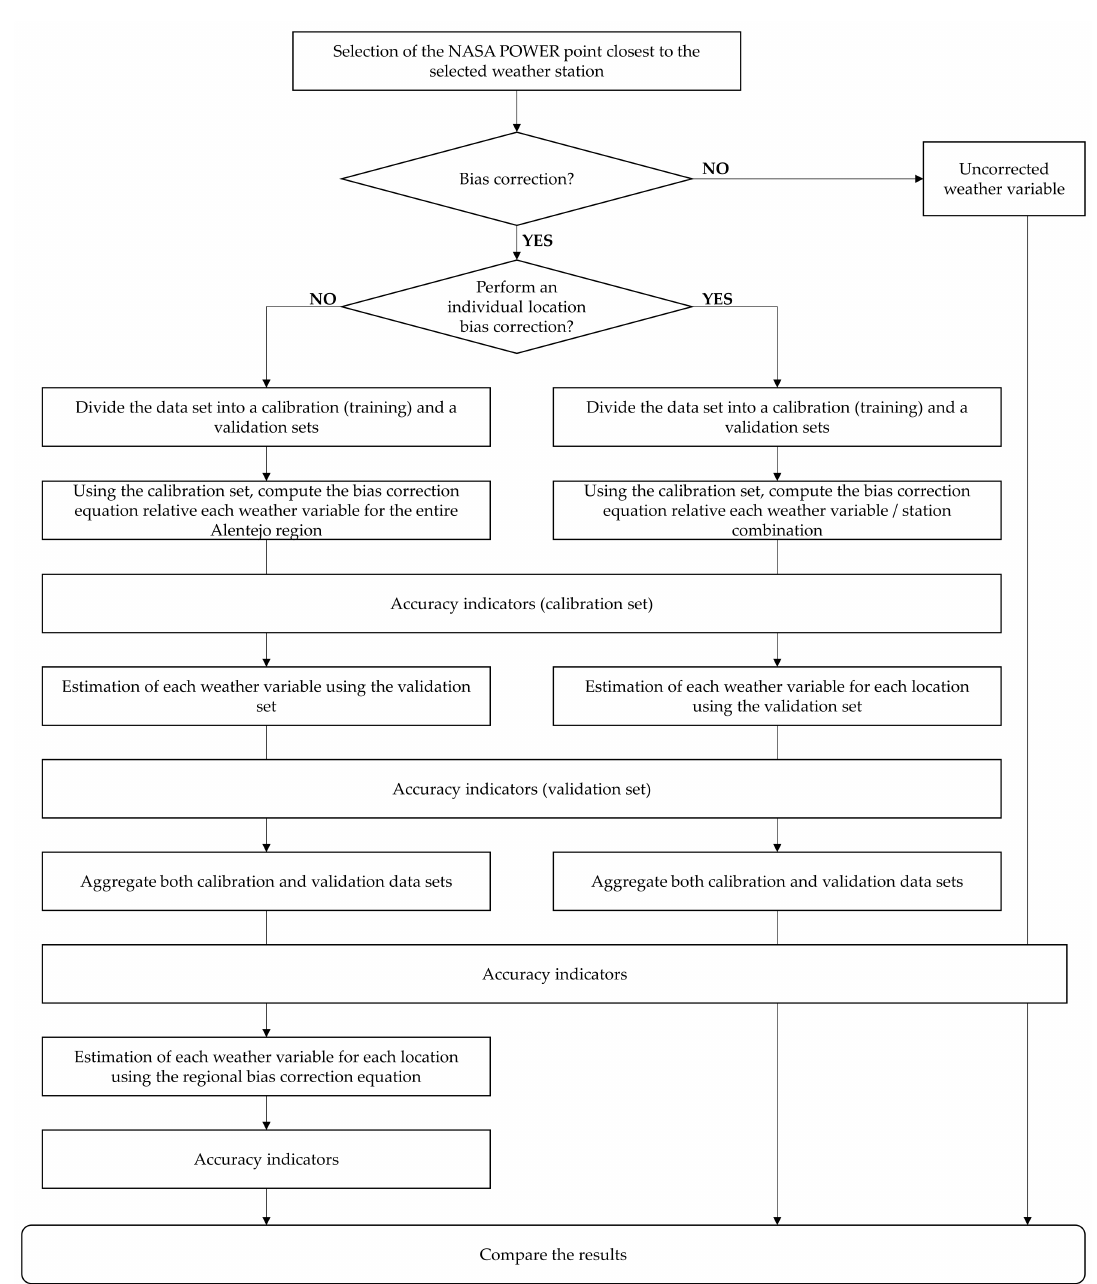
Figure 3. Flow chart presenting the procedures to correct the bias of NASA POWER data and comparing with observations using two bias correction